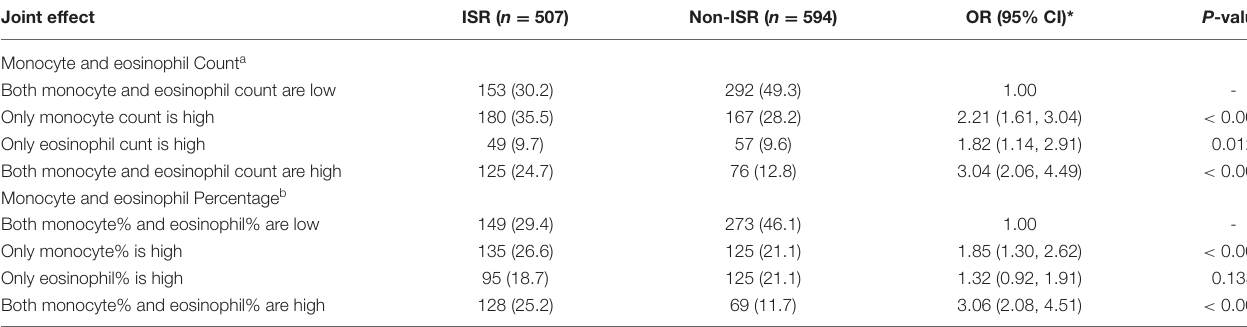
TABLE 4 | The joint effect of monocyte and eosinophil Count or percentage on the risk of postoperative in-stent restenosis (ISR). Joint effect